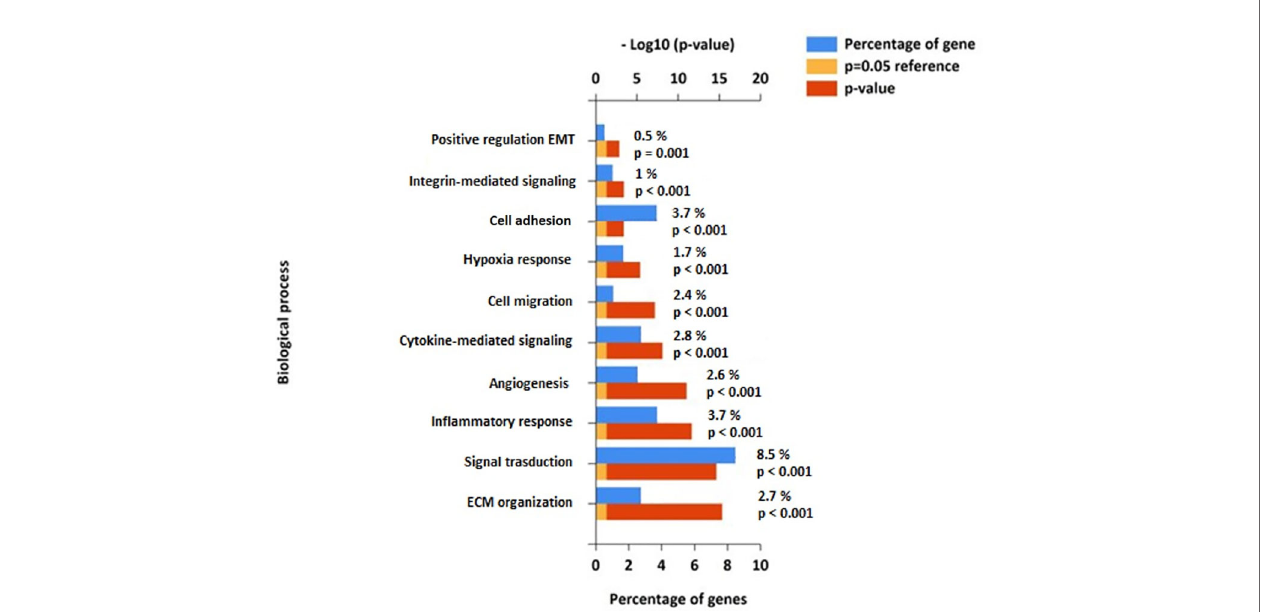
FIGURE 8 | Functional pathway enrichment analysis of genes correlated to Cav-1 from the FunRich database (39). The Figure shows the top 10 biological highly populated canonical pathways from the analysis of 4879 genes related to Cav-1. Blue bars represent the percentage of genes assigned to the indicated pathway, orange bars show the reference p value (0.05), and red bars show the calculated p value of enrichment for the indicated term. Biological processes are ranked based on -